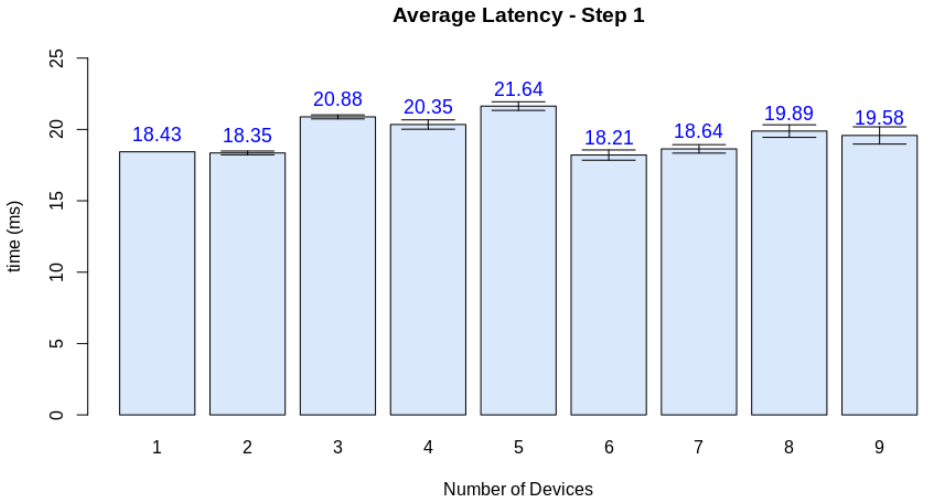
Figure 26. Latency test results for step